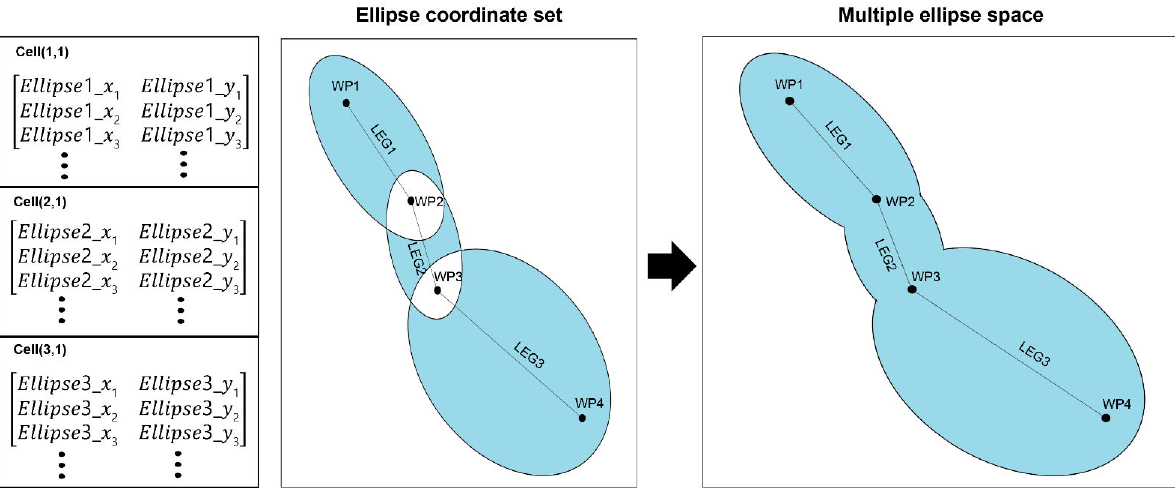
Figure 13. The multi ‐ ellipse space created for the RRT* algorithm.